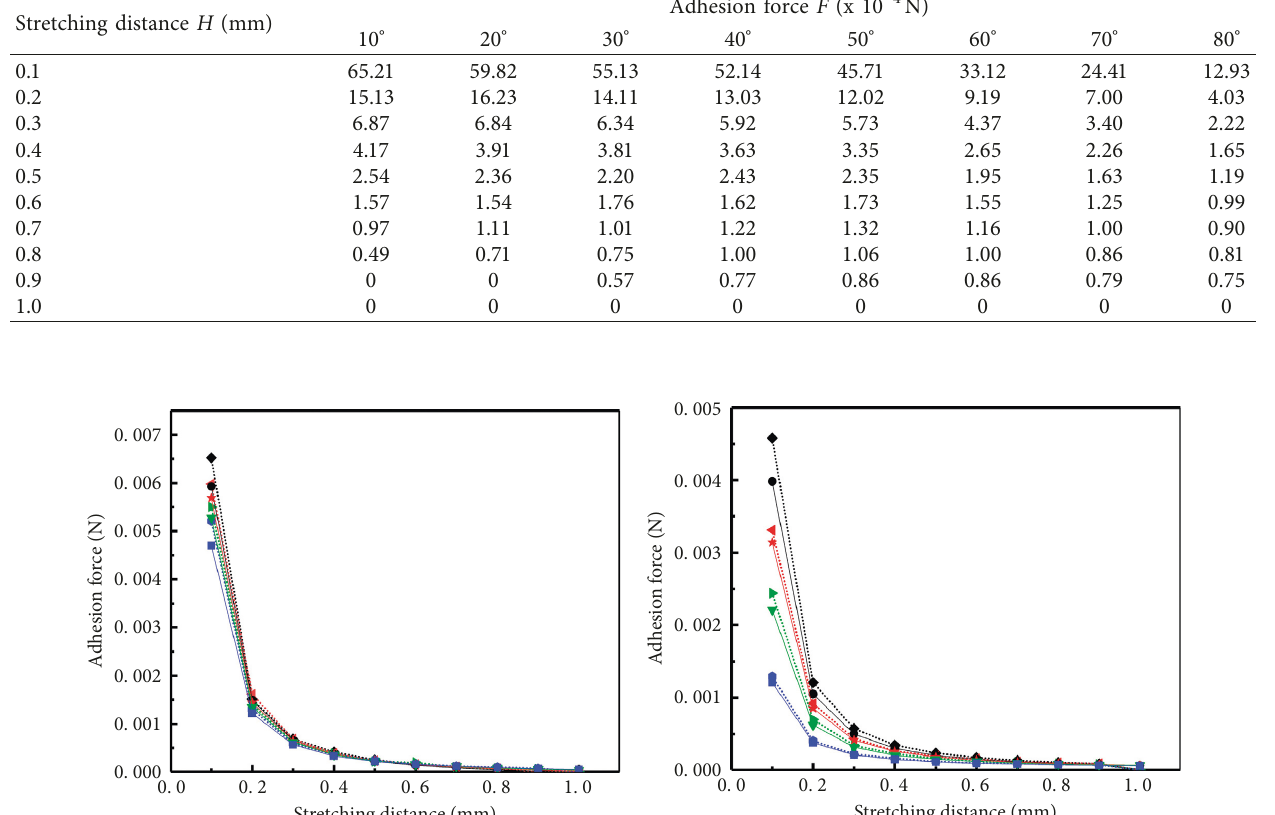
Table 4: Simulation values of adhesion force of liquid bridge under different contact angles. Stretching distance H (mm)